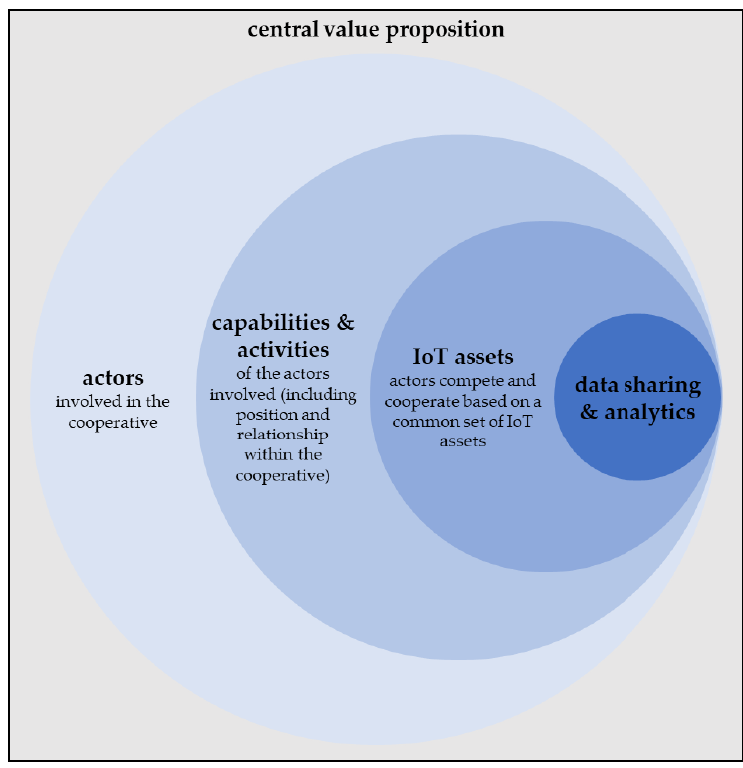
Figure 2. Tiers of an IIoT ecosystem, based on [5,14].